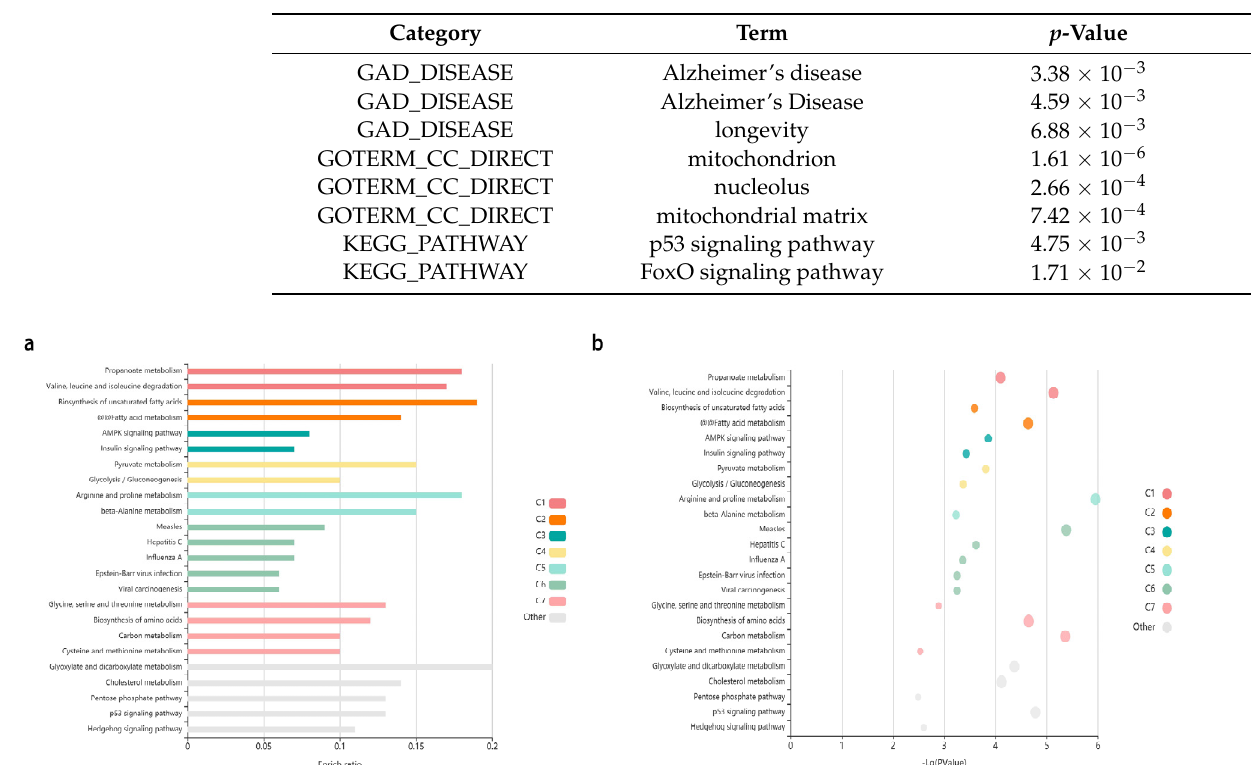
Table 4. Enrichment analysis results of differentially expressed genes related to aging (based on transcriptome analysis).